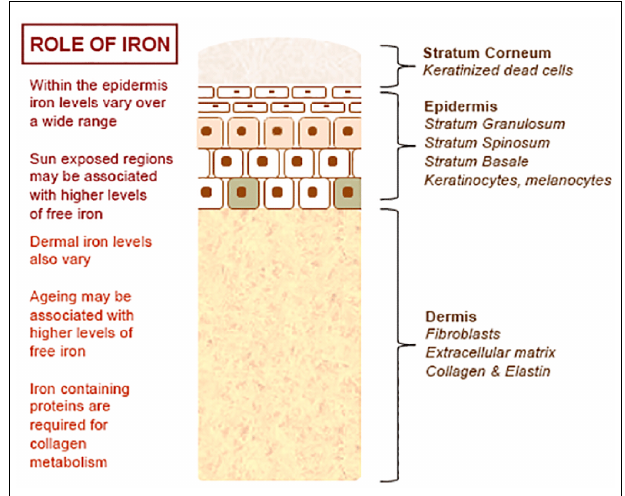
FIGURE 1 | Role of iron in the skin – an overview.